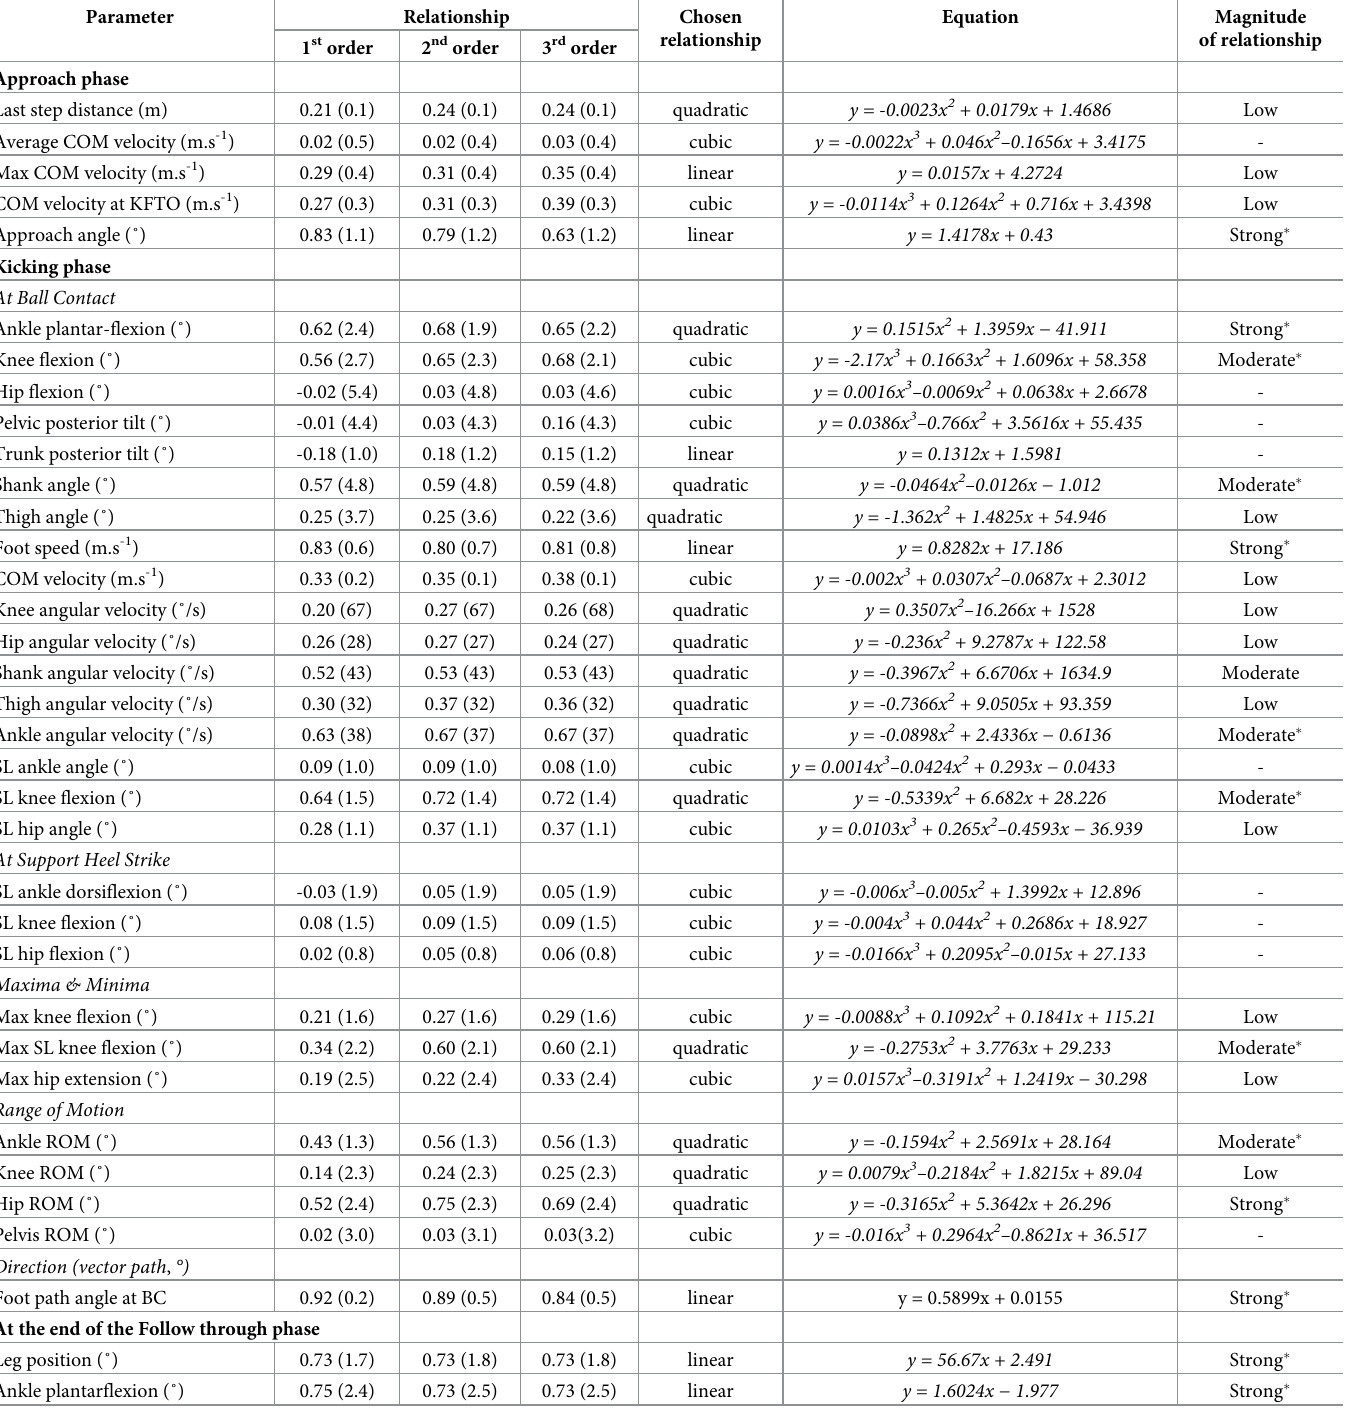
Table 3. The relationship between kinematic parameters and accuracy. Linear, quadratic and cubic curve estimations for each parameter ( r 2 values (SEE)), with the chosen relationship and magnitude of relationship identified. All parameters relate to the kick-leg unless